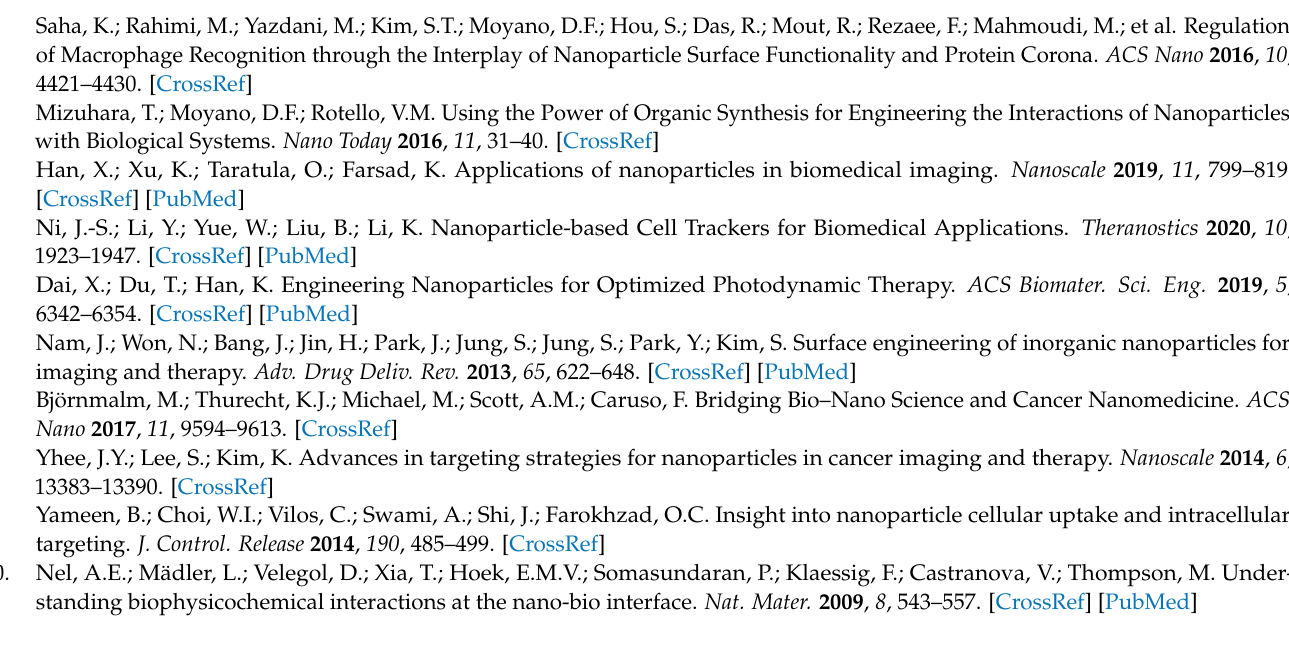
QDs; Table S1: DLS measurements of QD NAs and mAb-QD NAs; Figure S3: Western blot analysis of CD44 expression in MDA-MB-231 and NIH 3T3 cells; Figure S4: Cell viability upon incubation with mAb-QD NAs; Figure S5: Representative confocal microscopy images of cells incubated with mAb-QD NAs; Figure S6: Flow cytometry